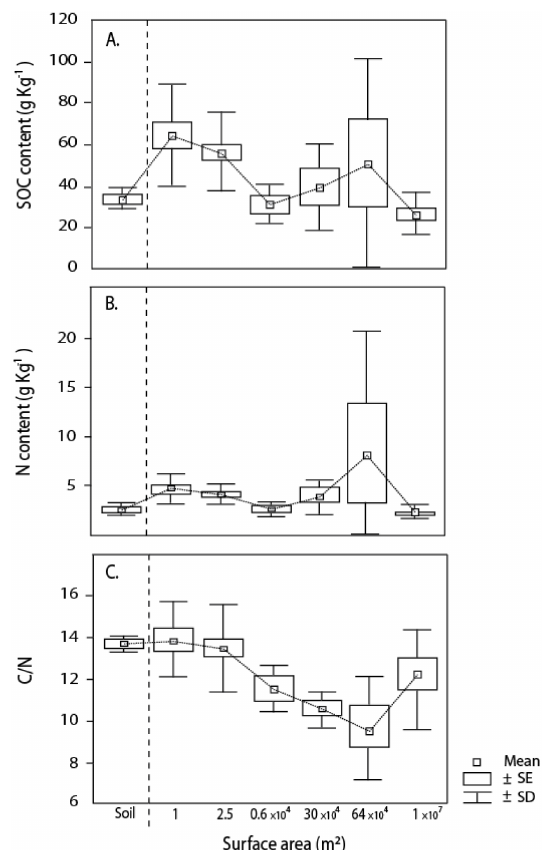
Figure 2. Organic carbon (A) , nitrogen content (B) and C/N ratio (C) for the bulk soil and sediments collected at the different spatial scales under study. Mean values, standard errors and standard devi- ations were computed from the different plot repetitions and from the 34 rainfall events under